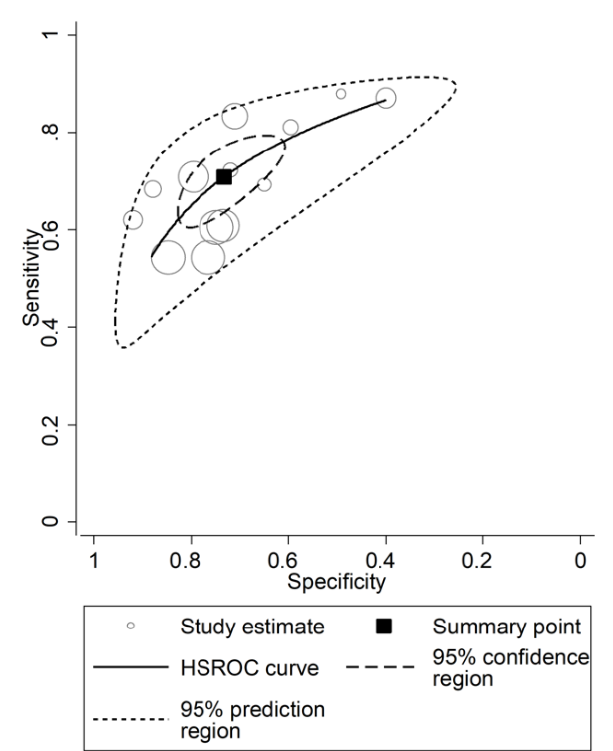
Figure 16. Empirical Bayes (posterior prediction) estimates of hierarchical receiving operating characteristic (HSROC) curve with 95% confidence region and prediction region for neutrophil-to-lymphocyte ratio in adverse outcome prediction.